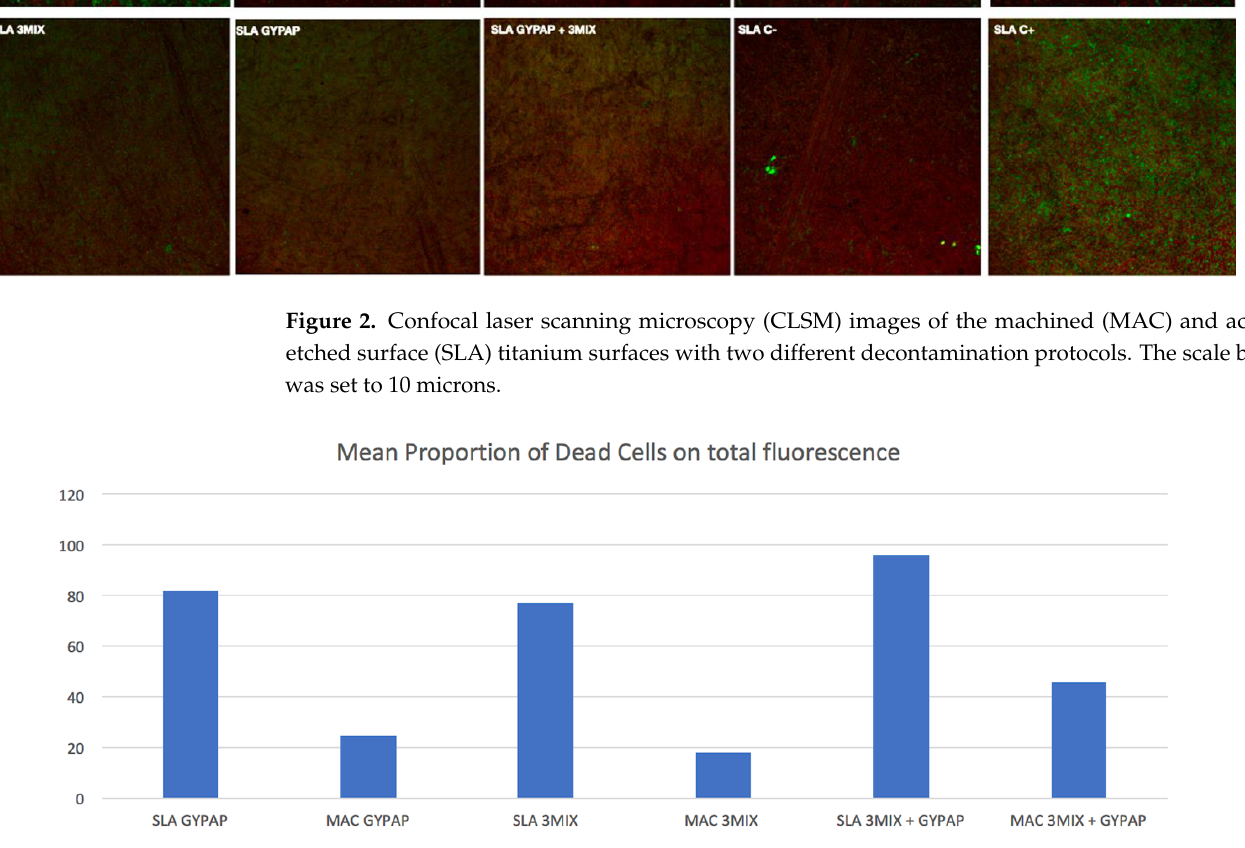
Figure 3. Proportion of dead cell volume of the machined (MAC) and acid etched surface (SLA) titanium surfaces treated with two different decontamination protocols. X-axis indicates the treatment’s protocol groups. Y-axis indicates the mean proportion (%) of dead cells.